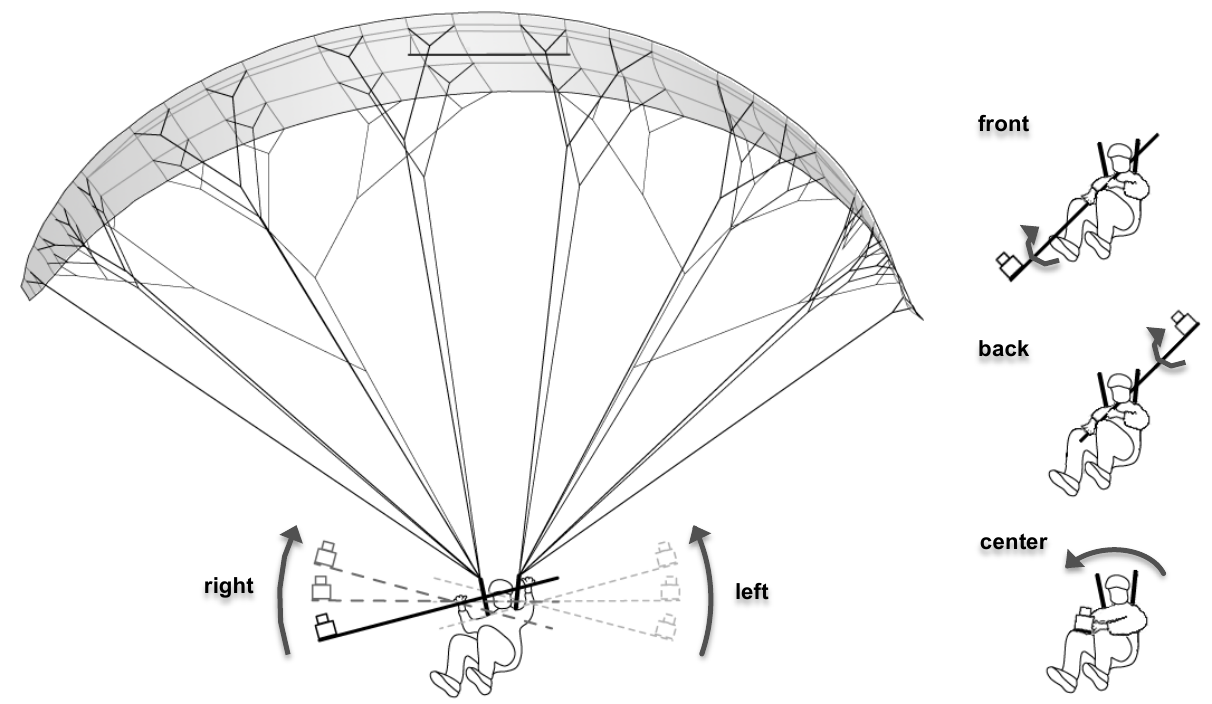
Fig. 3: Schematic view of the camera positions in flight direction